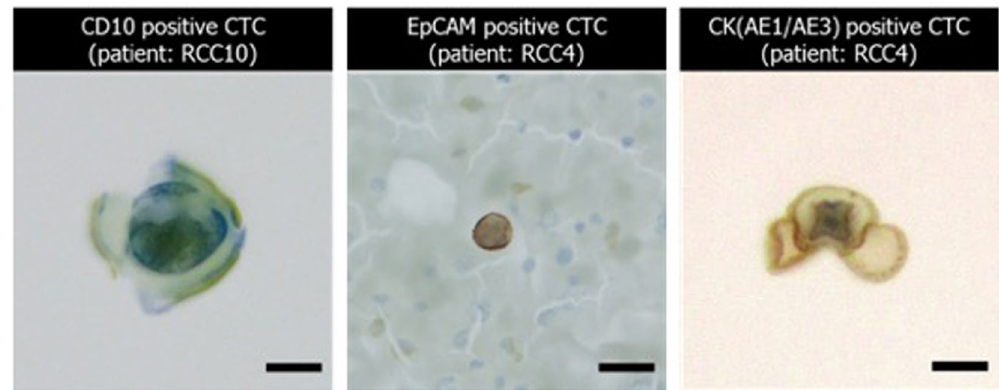
Figure 7. The representative images of the isolated circulating tumor cells from the patients with renal cell carcinoma by using multi-physical CTC isolation method (Scale bar = 20 μ